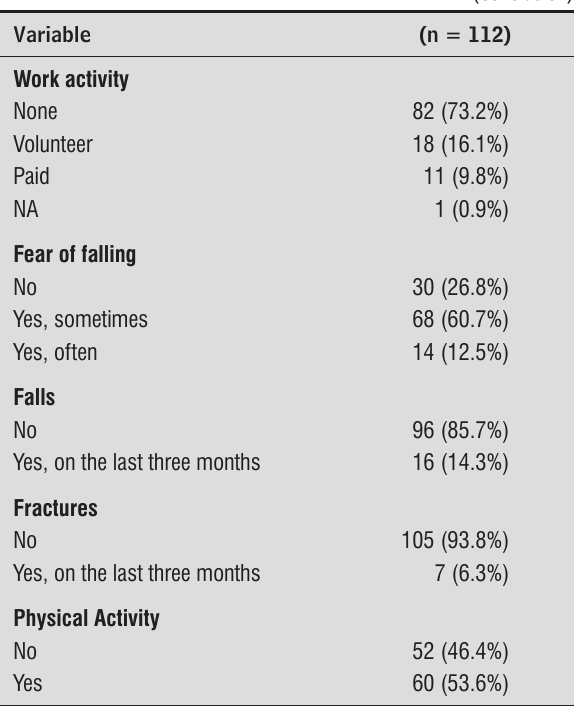
Table 1 - Sociodemographic and clinical characteristics of the participants